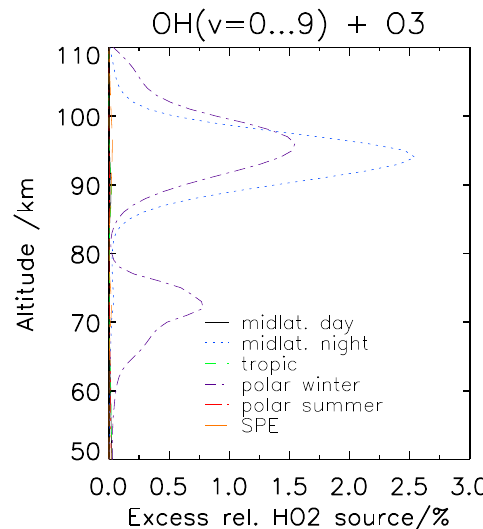
Fig. 9. Excess relative HO2 source by consideration of vibrationally excited OH in the OH+O 3 reaction as a function of altitude for various atmospheres.